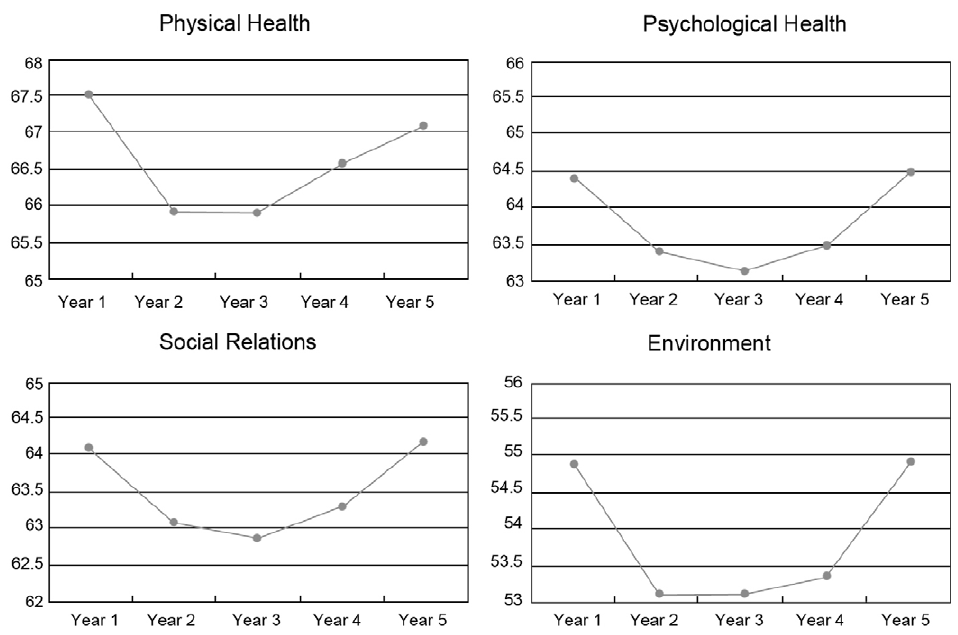
Figure 3. Scores of each domain for preventive medicine.